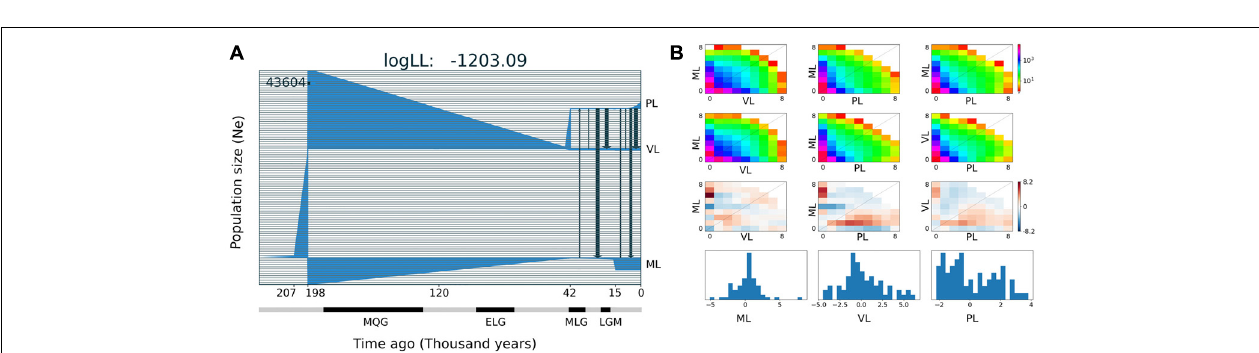
FIGURE 4 | Proportions of ancestry for specimens of Abrothrix hirta from seven groups of localities into three genetic clusters. The three genetic clusters (K = 3; see Supplementary Figure 1 ) are differently colored (red, blue, and green). The black bar below indicates the limits of each of the seven population groups ( Figure 1 ). Samples and localities included in each group are specified in Table 1 .